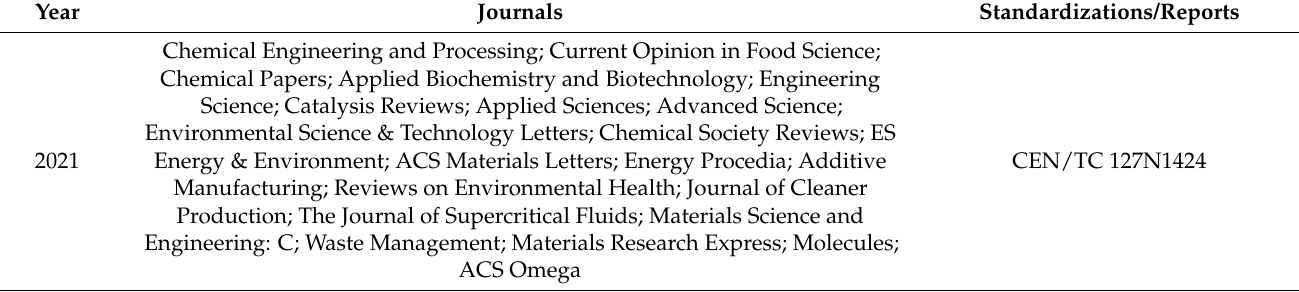
Table 2. List of journals that have appeared in the co-occurrence network in the last two years. Year Journals